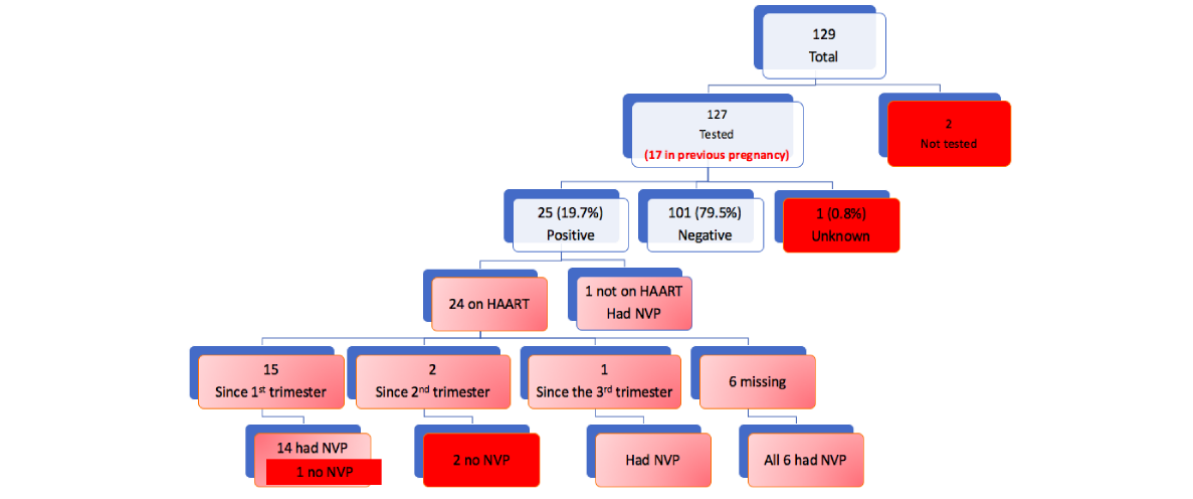
Figure 5. HIV status of mothers of babies admitted to neonatal unit using the NeoTree app. HAART: highly active antiretroviral therapy; NVP: